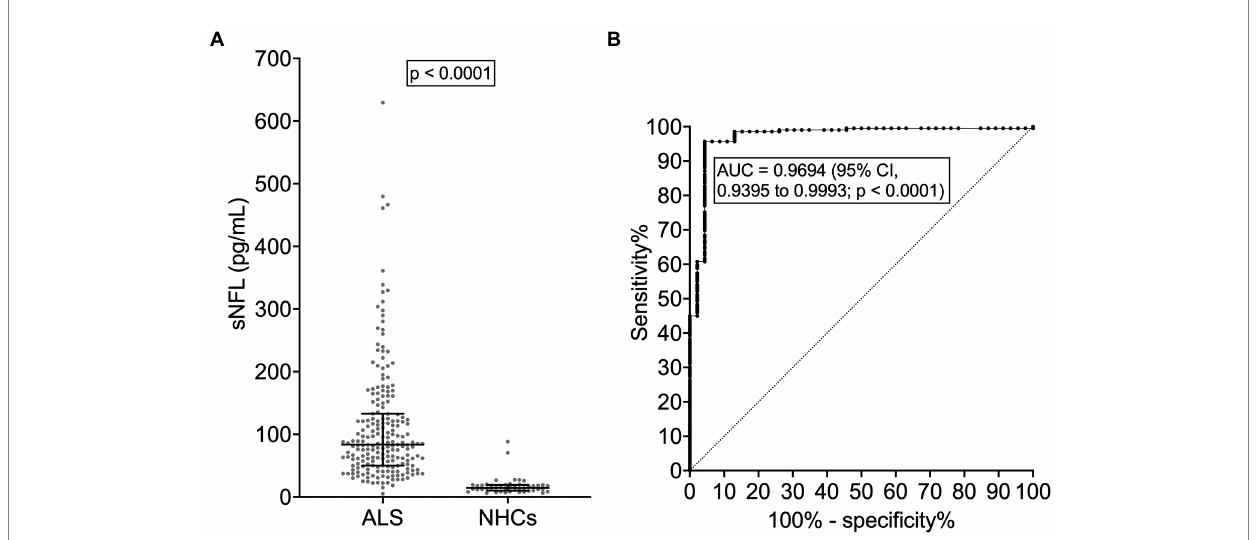
FIGURE 1 Serum NFL levels in ALS patients and neurologically healthy controls. (A) sNFL levels in ALS patients and NHCs. Wide horizontal bars represent median values, narrower horizontal bars represent first and third quartiles. (B) ROC curve of the discrimination between ALS patients and NHCs. ALS, amyotrophic lateral sclerosis; AUC, area under the curve; CI, confidence interval; NFL, neurofilament light chain; NHCs, neurologically healthy controls; ROC, receiver operating characteristic; sNFL, serum neurofilament light